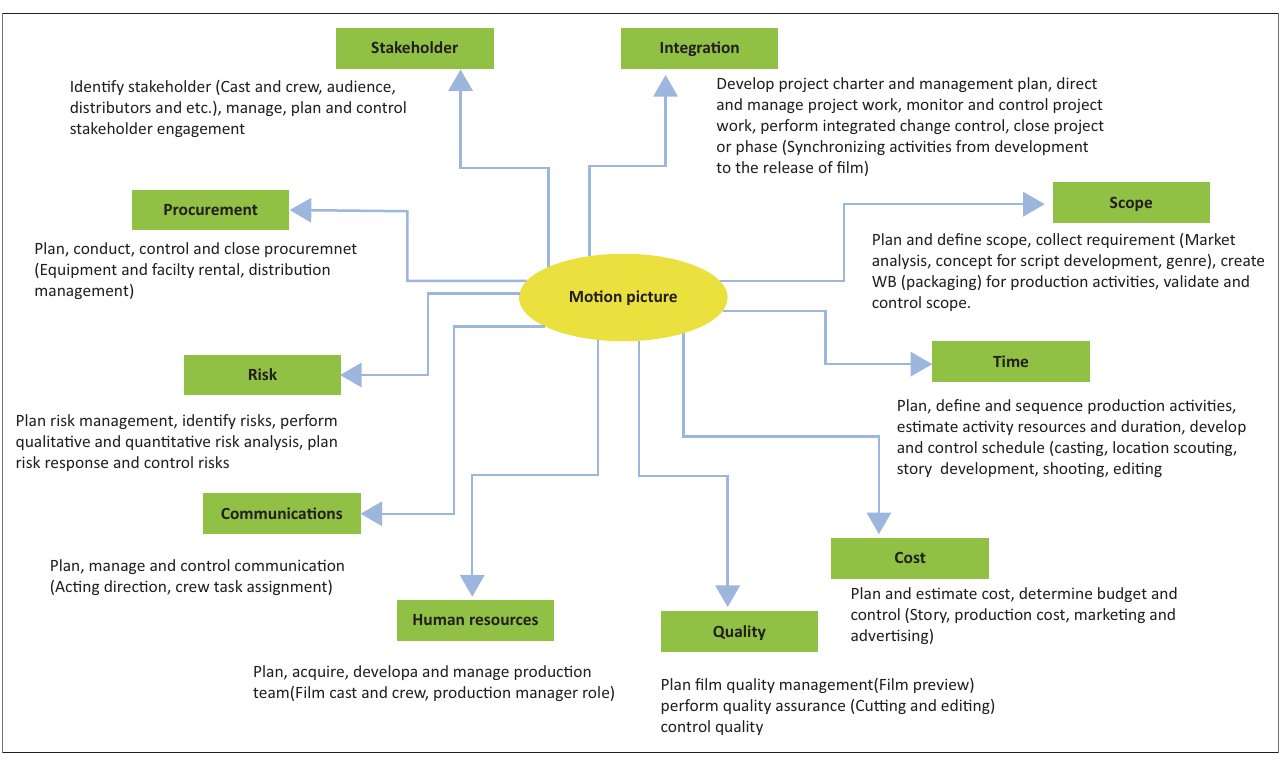
Iden(cid:27)fy stakeholder (Cast and crew, audience, distributors and etc.), manage, plan and control stakeholder